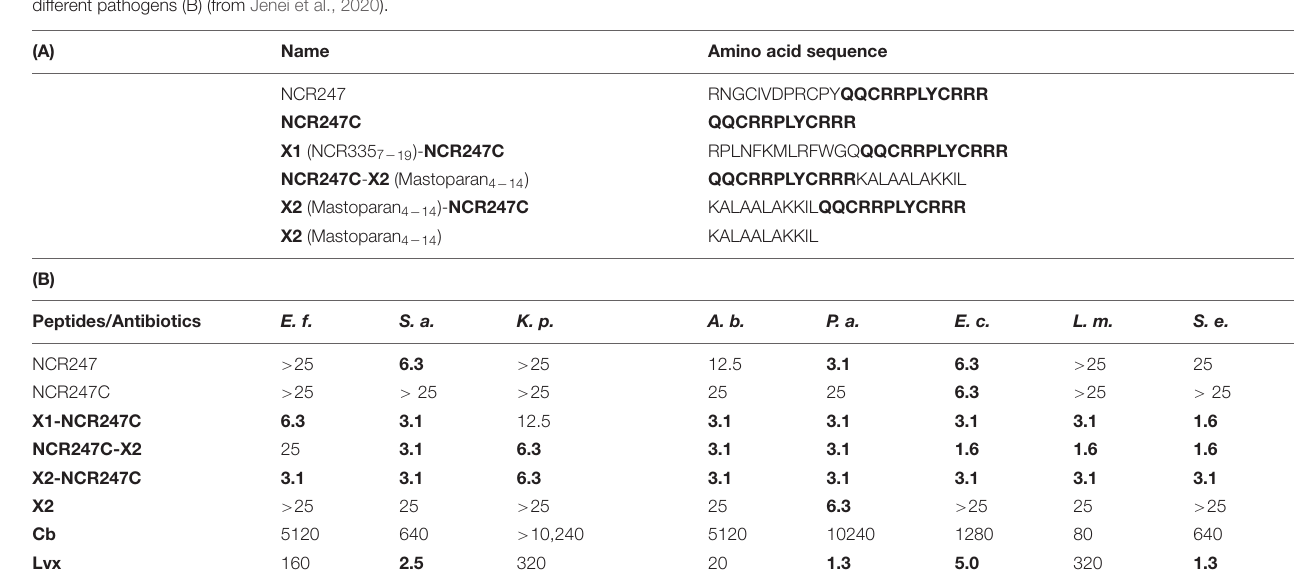
TABLE 1 | The amino acid sequence of NCR247 and its derivatives (A) and the minimal bactericidal concentrations (MBCs) of these peptides and antibiotics (in µ M) on different pathogens (B) (from Jenei et al.,